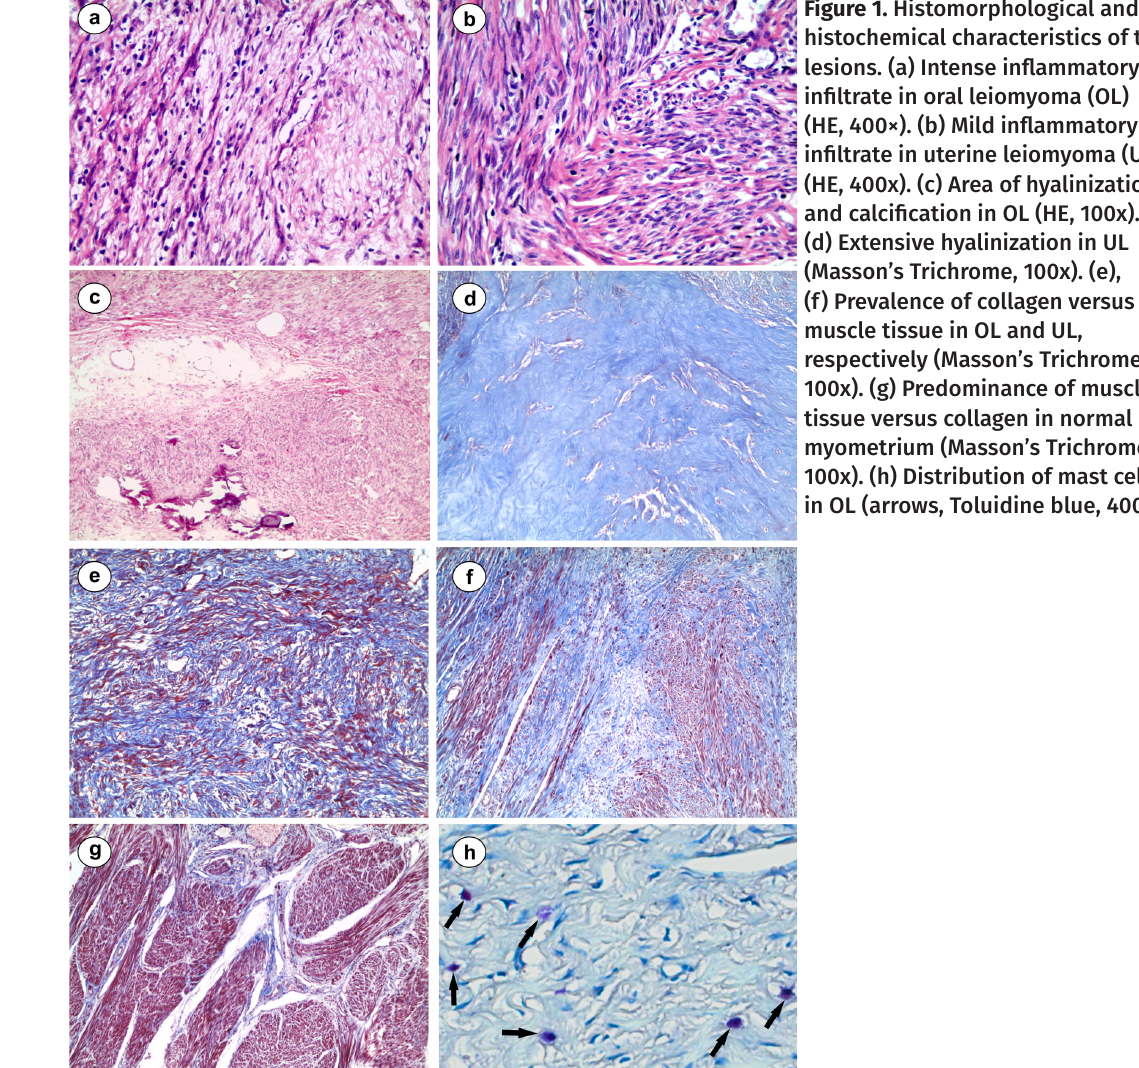
Figure 1. Histomorphological and histochemical characteristics of the lesions. (a) Intense inflammatory infiltrate in oral leiomyoma (OL) (HE, 400×). (b) Mild inflammatory infiltrate in uterine leiomyoma (UL) (HE, 400x). (c) Area of hyalinization and calcification in OL (HE, 100x). (d) Extensive hyalinization in UL (Masson’s Trichrome, 100x). (e), (f) Prevalence of collagen versus muscle tissue in OL and UL, respectively (Masson’s Trichrome, 100x). (g) Predominance of muscle tissue versus collagen in normal myometrium (Masson’s Trichrome, 100x). (h) Distribution of mast cells in OL (arrows, Toluidine blue,